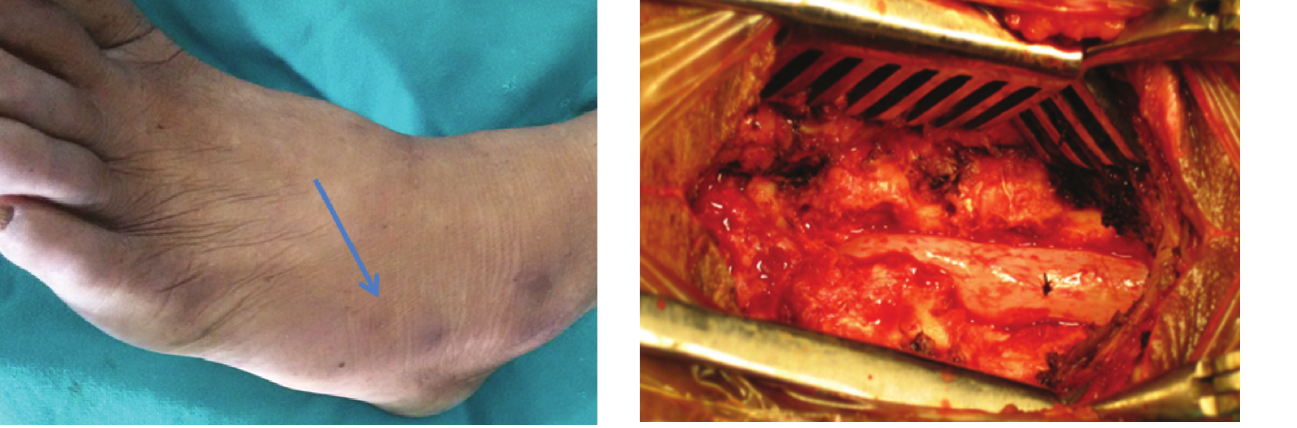
stenosis.Figure 1. Extensor digitorum brevis (EDB) wasting (arrow head) in a patient with lumbar canal